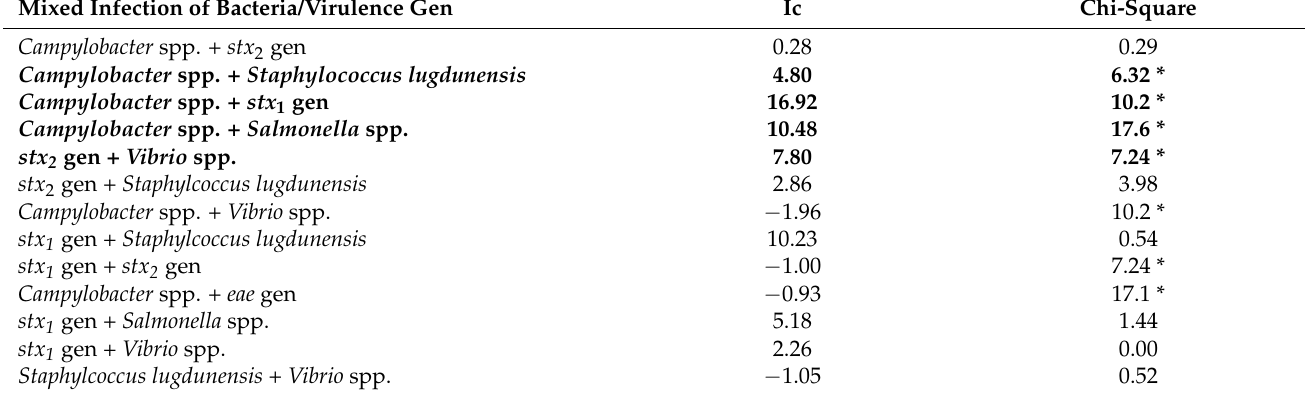
Table 5. Index of co-infection (Ic) for the different co-infections obtained from Anolis